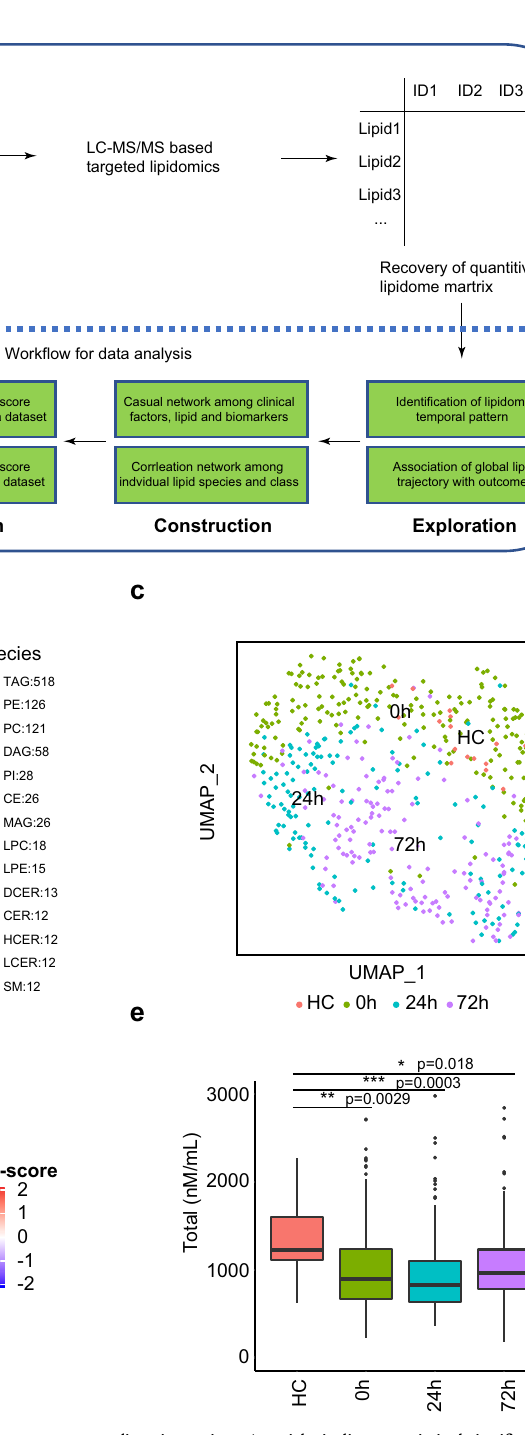
sampling timepoints. Asterisks indicate statistical signi fi cance based on the Kruskal – wallis test with post-hoc analysis using the Dunn test. The p value was adjusted by the Benjamini – Hochberg method: *<0.05; **<0.01; ***<0.001. Box and whisker plots represent mean value, standard deviation, maximum and minimum values, and outliers. TAG triacylglycerol, DAG diacylglycerols, MAG mono- acylglycerols, PE phosphatidylethanolamine, PC phosphatidylcholine, PI phos- phatidylinositol, LPE Lysophosphatidylethanolamine, LPC Lysophosphatidylcholine, CER Ceramides, HCER hexosylceramides, LCER lacto- sylceramide, DCER dihydroceramides, CE cholesterol ester. Source data are pro- vided as a Source Data fi le.